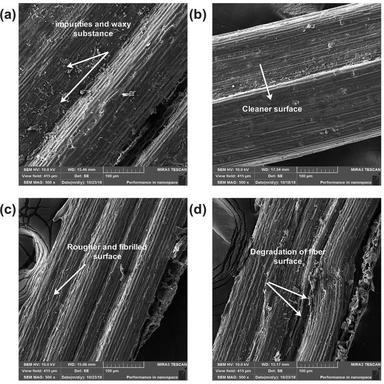
SEM images of (a) untreated (b) 3% treated (c) 5% treated (d) 7% treated fiber bundles.